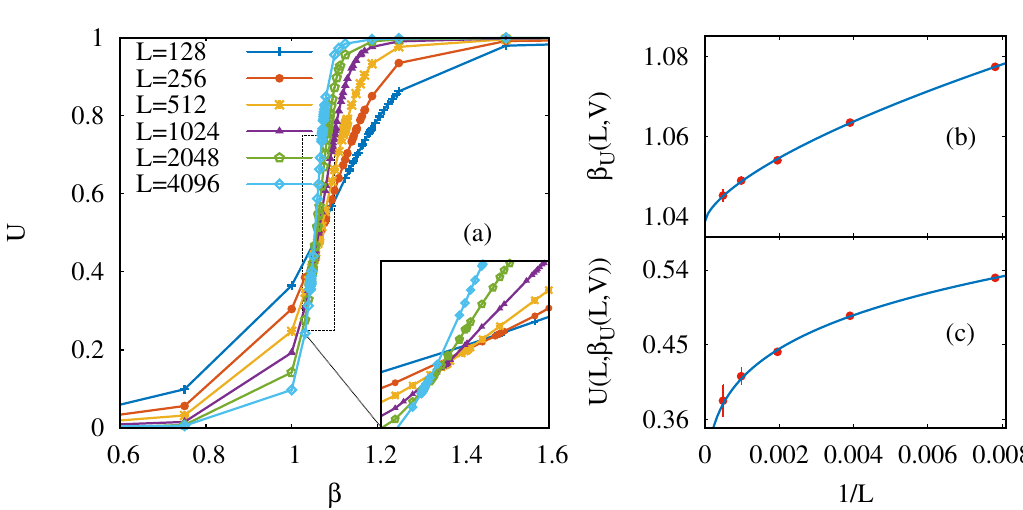
Figure 4: Binder cumulant scaling in the finite-temperature regime (in all panels, α = 1.50 and V = 5.0). Panel (a): Binder cumulant curves as a function of β for different system sizes. Solid lines are a guide to the eye. Inset: magnification of the ( L , V ) between the curve crossing region. Panel (b): computed crossing positions β U Binder cumulant curves at system sizes L and 2 L . The continuous line is a numer- ical fit to the expected FSS behavior in eq. (4). Panel (c): computed values of the ( L , V ) between system sizes L and 2 L . The Binder cumulant at the crossing points β U continuous line is a numerical fit to the predicted FSS behavior in eq. (5).